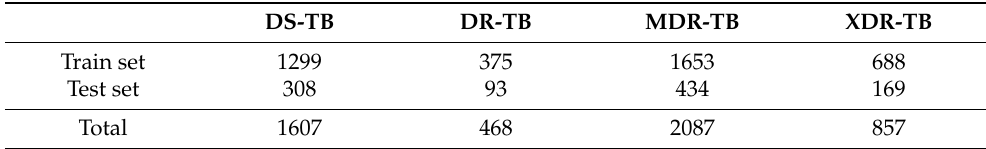
Table 1. Number of data of each category.